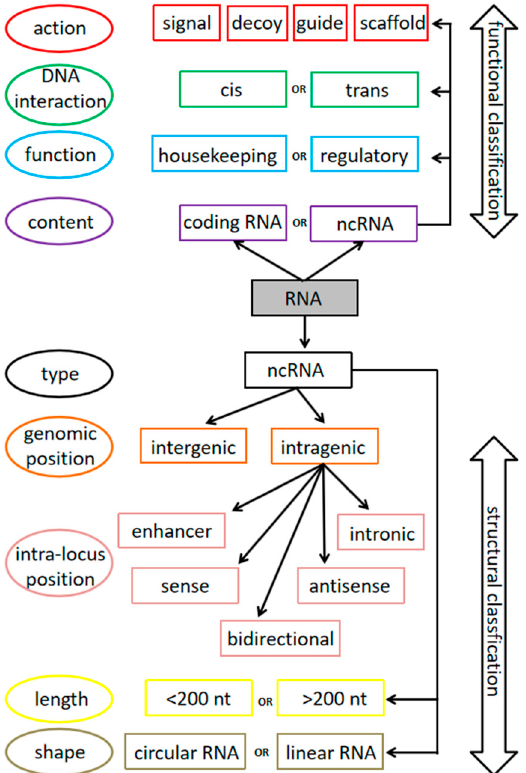
Figure 1. Classification of non-coding RNAs. Due to their highly heterogeneous nature, ncRNAs are classified according to several distinct variables. Although the most common parameter is their length, several other classifications are used, according to the context in which they are described. In general, the most common classifications rely either on functional aspects ( top ) or on the basis of structural features ( bottom ), as indicated by the double-headed arrows on the right. The different means of classification are depicted in the left column of the figure, inside the circles, while the corresponding RNA denominations are inside squares. Means and denominations are indicated in matching colors to ease the figure readability. To further complicate this scenario, any ncRNA can be assigned to more than one of the illustrated boxes. For example, MALAT1 (see text) is at the same time long, linear, sense, trans, and regulatory in nature [29]. 3. Competing Endogenous RNA Networks (ceRNETs): When lncRNAs and sncRNAs Interact Other than the abovementioned classification, in recent years a new category of ncRNAs has been identified based on functional assays. It has been repeatedly shown that miRs are able to interact not only with their target mRNA, but also with lncRNAs (Figure 2). In other words, the mRNA and lncRNA “compete” for the binding of the miR. On this basis, competing endogenous RNAs (ceRNAs) have been named to indicate this interaction. In this scenario, the lncRNA acts as a sponge for the miR and prevents its action on the mRNA, allowing its expression at the protein level. The deregulation of such interactions may cause alterations in cell homeostasis and be a cause of disease with an epigenetic basis. This deregulation has been found in several human diseases, including cardiovascular anomalies [33], neurodegenerative disorders [34,35], and various types of cancer [36–38], such as those of the urogenital apparatus [39–42]. This has a deep effect in cancer; in fact, if the target mRNA encodes for an oncosuppressor, the miR that targets it acts as an oncogene (because it inhibits the expression of an oncosuppressor), and in turn the lncRNA that sponges the miR acts as an anti-oncogene (and functionally as an oncosuppressor as well); the same logic but with opposite effects